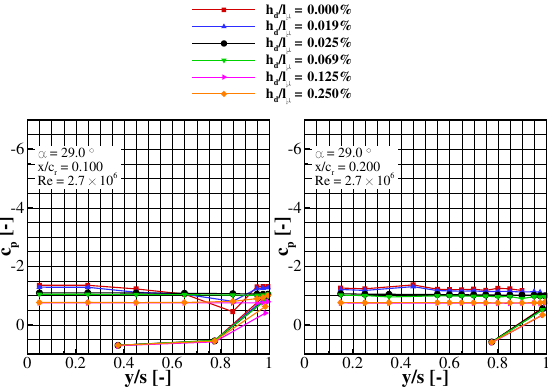
Figure 12. Leading-edge roughness effect on the spanwise mean surface pressure distribution in the apex region ( x / c r = 0.1 and 0.2) , at Re = 2.7